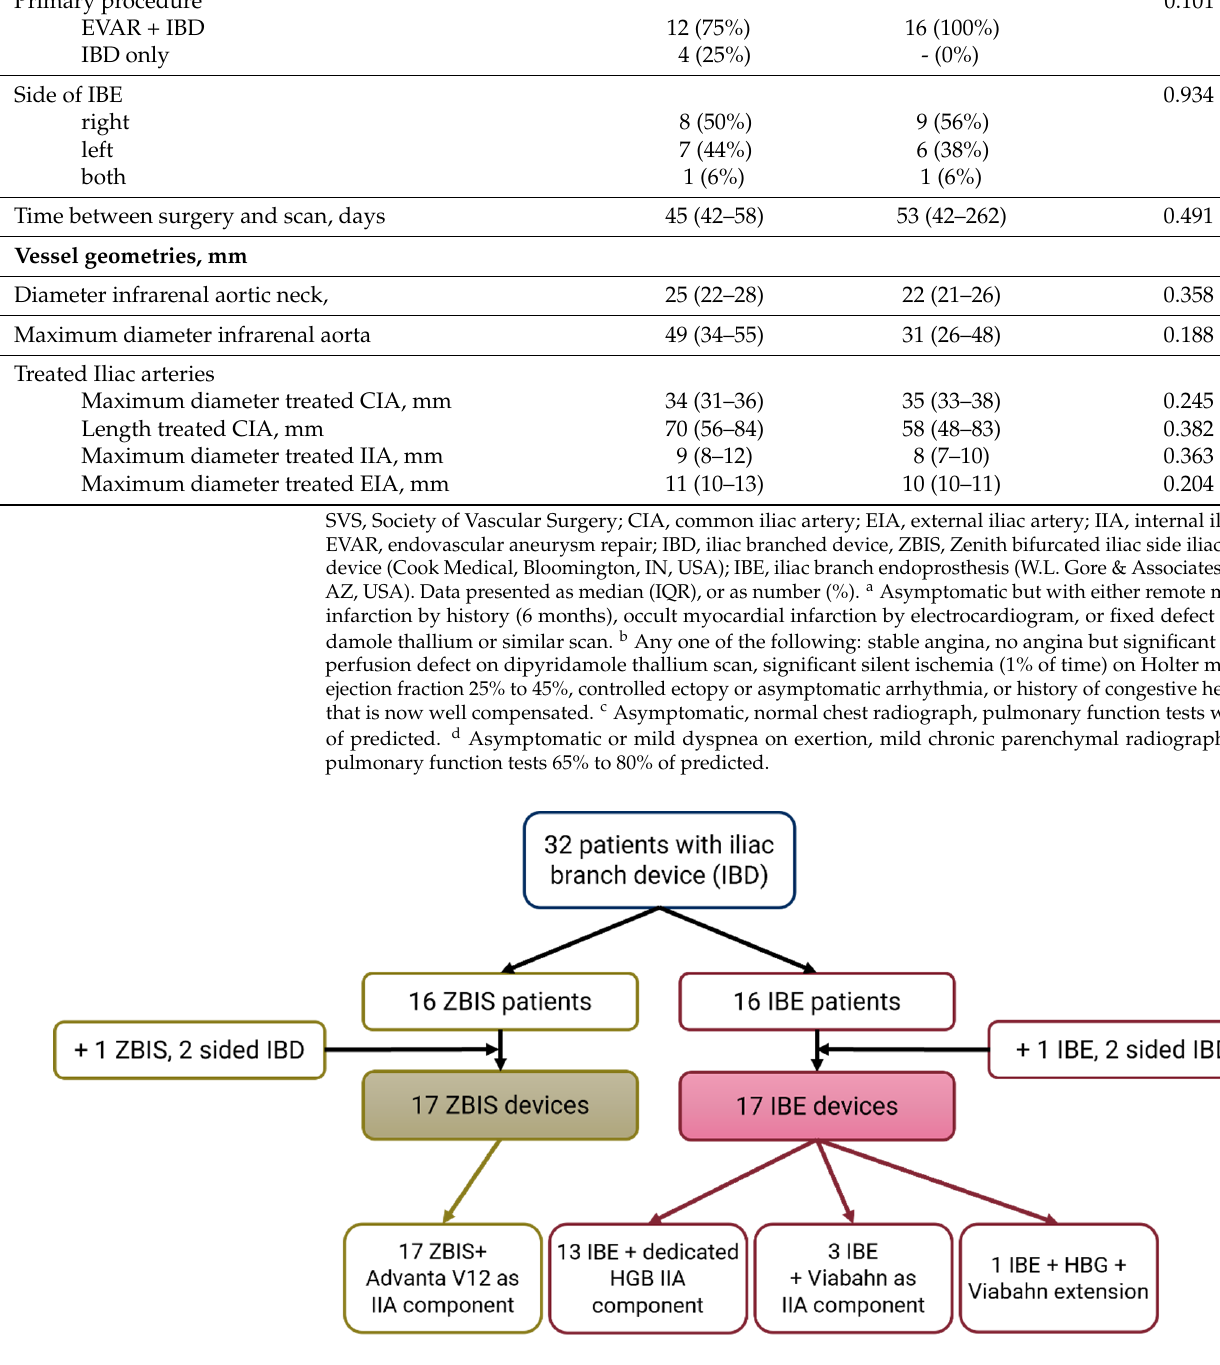
Figure 3. Flowchart of the included iliac branch device (IBD) patients. The Cook Medical Zenith bifurcated iliac side (ZBIS) was in all cases combined with the Advanta V12 balloon-expandable